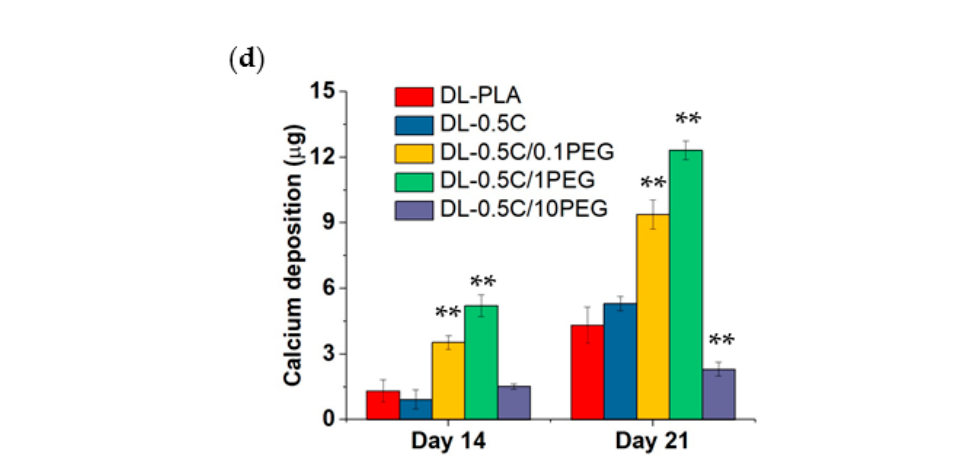
Figure 7. ( a ) The accumulative release of DEX from nanofibers was evaluated by incubating in PBS at 37 ◦ C. (*: p < 0.05, **: p < 0.01 compared to the DL-PLA group). ( b ) Water contact angles of DEX-loading nanofibers were evaluated immediately and placing in PBS for 4 days. (*: p < 0.05, **: p < 0.01 compared to the results of day 0). ( c ) The effect of nanofibers on promoting osteogenesis was evaluated by seeding rBMSCs for 14 and 21 days, and the mineralized tissues were stained by Alizarin Red S. (scale bar = 500 µ m). ( d ) Calcium deposition by the differentiated rBMSCs was analyzed by the Ca- o -CPC complex method. (**: p < 0.01 compared to the DL-PLA group).